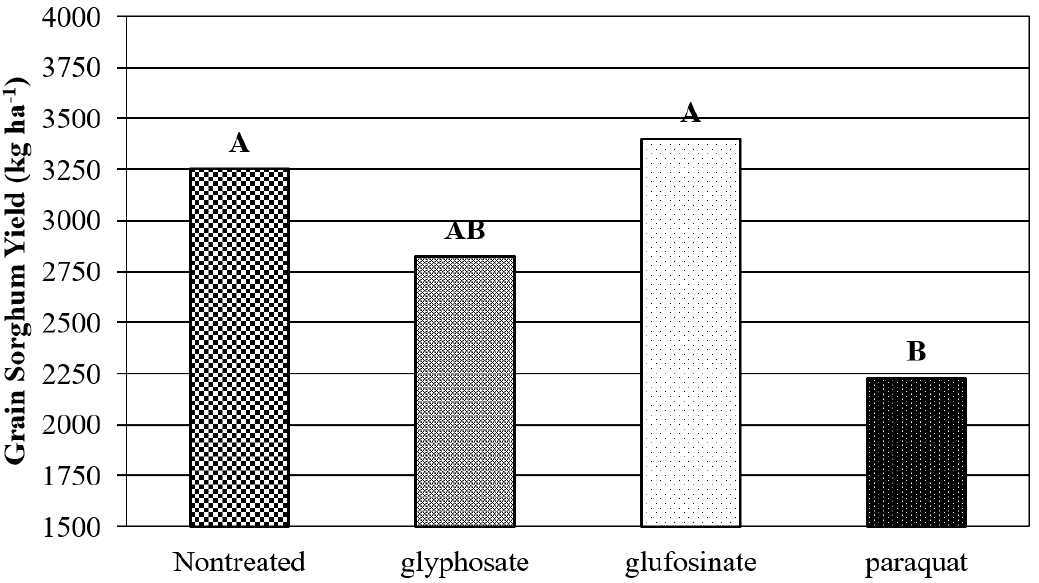
Figure 6. Grain sorghum yield as affected by herbicide drift of glyphosate, glufosinate, and paraquat in 2017. Data is averaged over application timing. Same letters on bars indicate no significant differences at p < 0.05, according to Fisher’s least significant difference test.